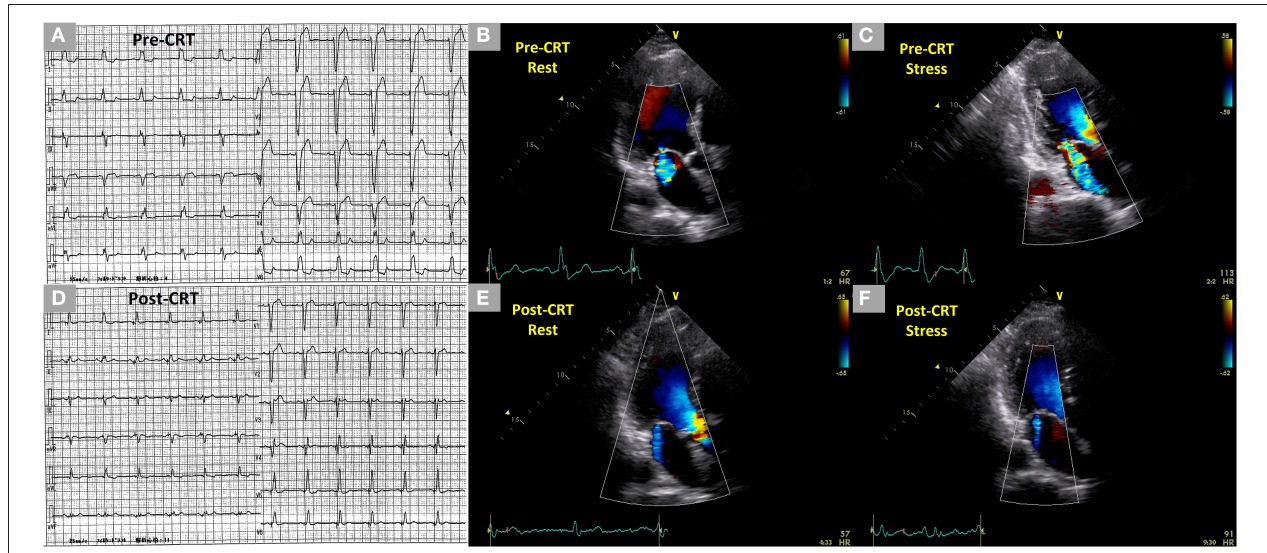
FIGURE 3 | Dynamic changes of SMR during exercise stress echocardiography before CRT and controlled SMR following CRT during exercise stress echocardiography in a 71-year-old male patient who had an anterior old myocardial infarction and heart failure with reduced ejection fraction. (A) Complete left bundle branch block with a QRS duration of 154ms in the electrocardiogram before CRT. (B,C) Mild SMR (EROA 0.14 cm 2 ) at rest and dynamic moderate-to-severe SMR (EROA 0.32 cm 2 ) under stress in two-dimensional color Doppler images from the three-chamber view before CRT. (D) Non-left bundle branch block with a QRS duration of 128ms in the electrocardiogram after CRT. (E,F) Trivial SMR at rest and under stress 1 year after the CRT in two-dimensional color Doppler images from the three-chamber view after CRT. SMR, secondary mitral regurgitation; CRT, cardiac resynchronization therapy, EROA, effective regurgitant orifice area.